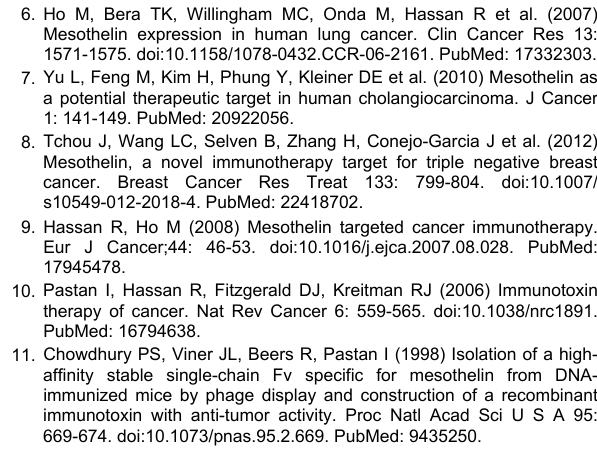
Complete blood counts and serum chemistry